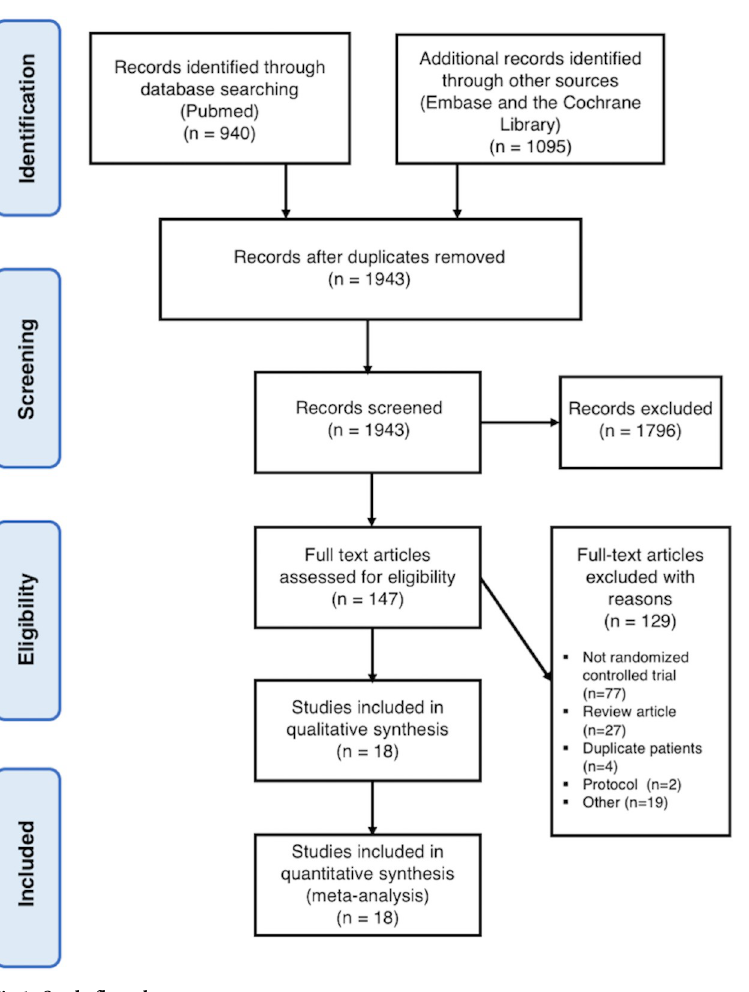
Fig 1. Study flow chart.